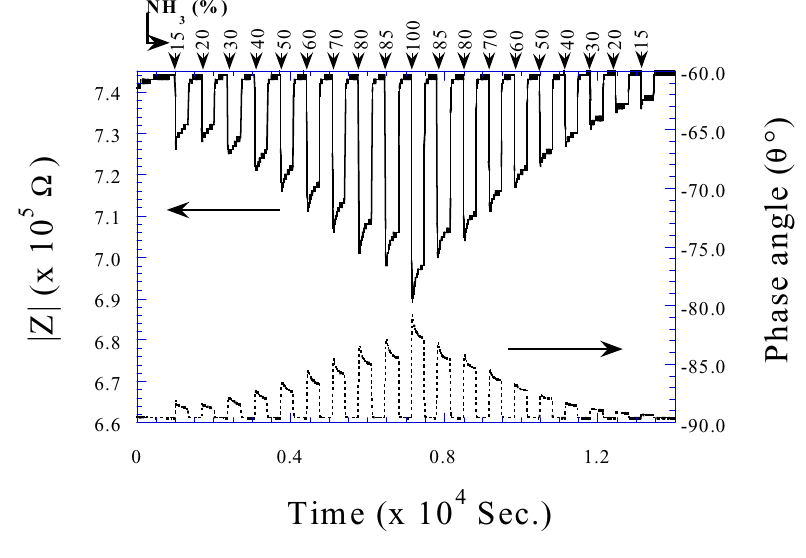
Figure 16. Change in impedance magnitude and phase of sensor SO50 in response to changing ammonia concentration. Argon is used as the carrier gas. The sensor response is completely